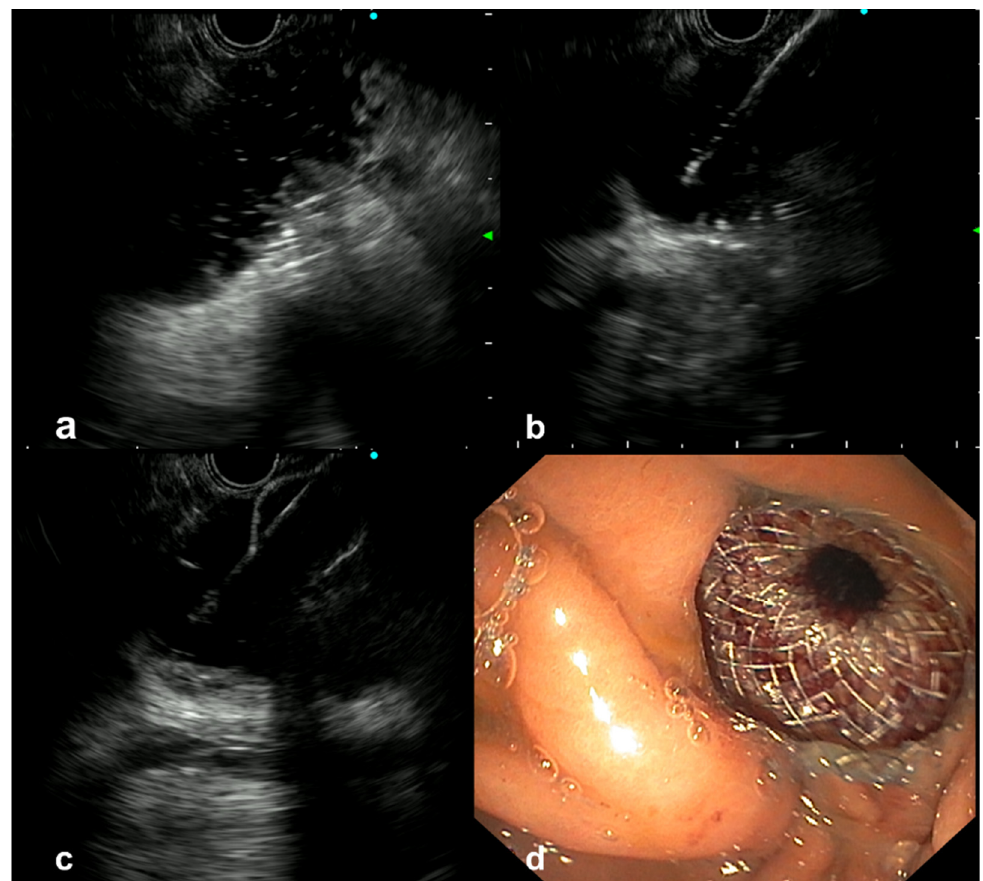
Figure 1. Endoscopic ultrasound-guided gastroenterostomy (EUS-GE). ( a ) The proximal jejunal limb was dilated by using the oroenteric catheter. The hyperechogenic spots are the contrast. ( b ) A free-hand gastrojejunal perforation was made by using the catheter of the lumen-apposing metal stent (LAMS). ( c ) Deployment of the distal flange of the stent under EUS control. ( d ) Endoscopic view of the proximal flange of the LAMS completely deployed.